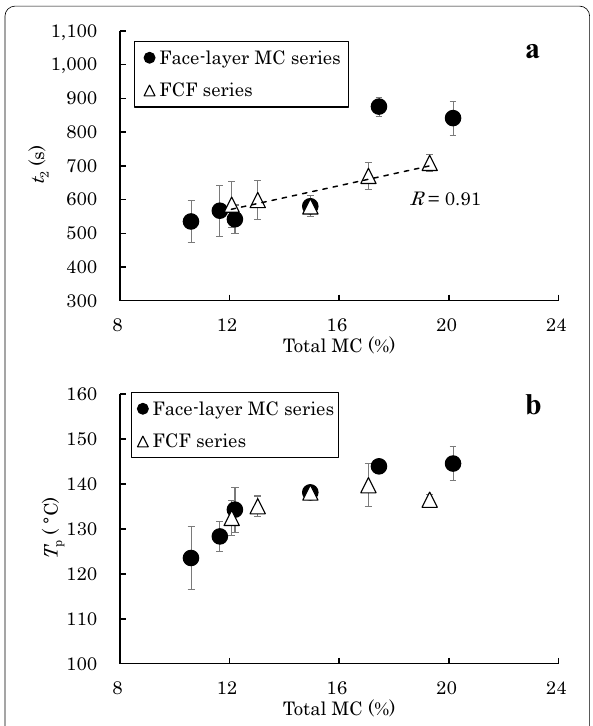
Fig. 9 Relationship between VP max and T p : the solid and dashed lines are the Antoine correlation fits to the empirical data and water,